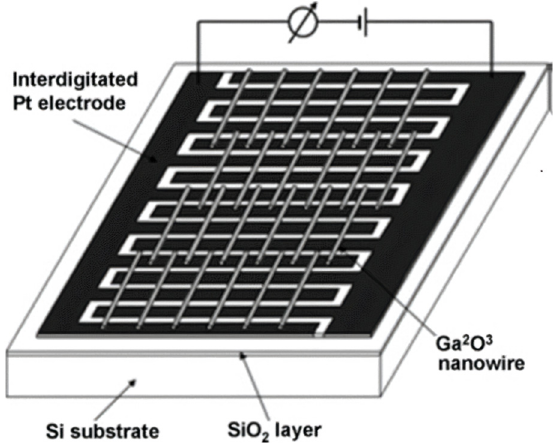
Figure 15. The gas sensor made from Ga 2 O 3 nanowires [185]. “Reprinted with permission from Ref. [185]. Copyright (2008), Elsevier.”.